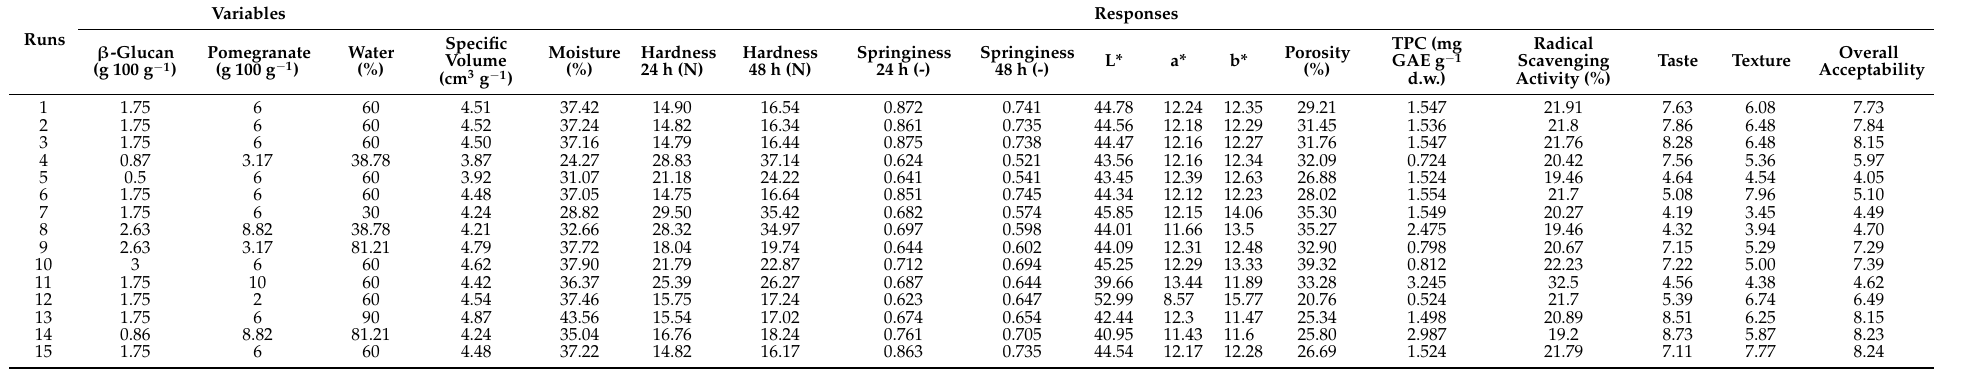
Table 2. The central composite rotatable design with process variables and experimental results of